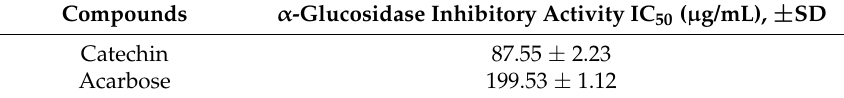
Table 1. The α -glucosidase inhibitory potency of catechin.